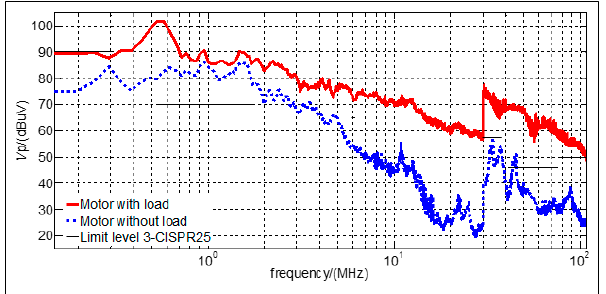
Figure 3. Comparison of measurement with load and measurement without load.